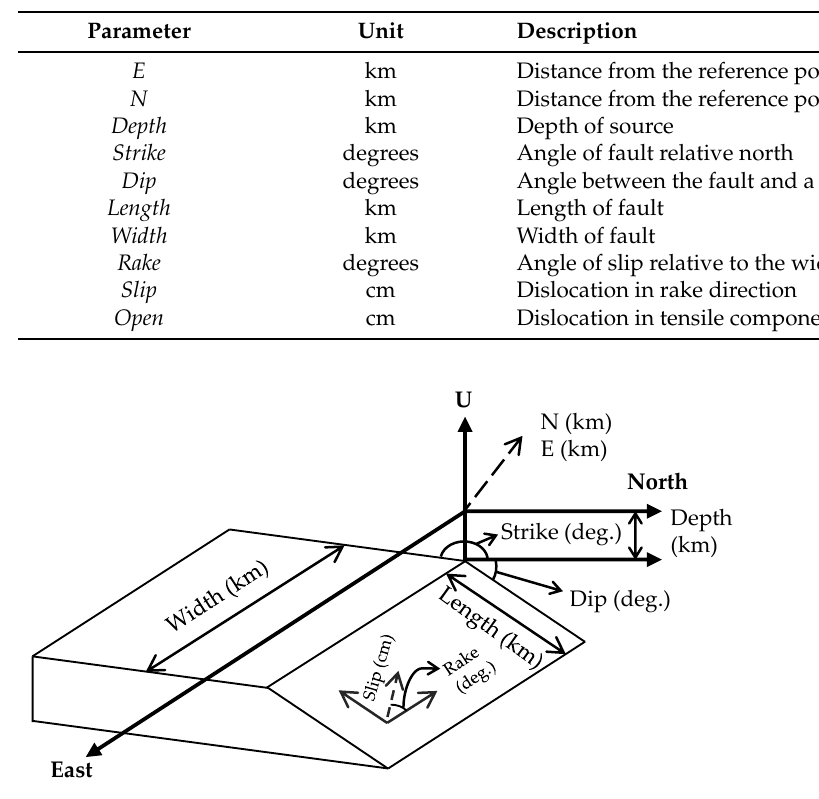
Table 2. Source parameters of the Okada model.